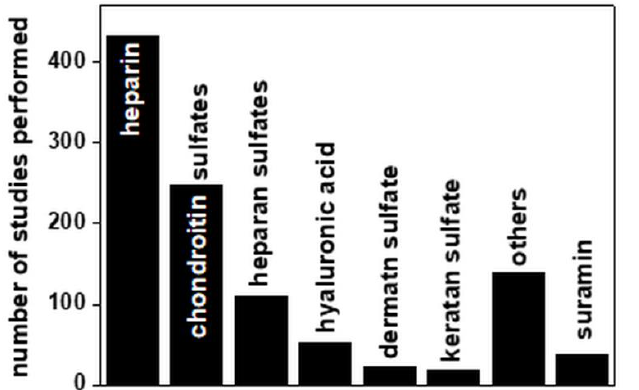
Figure 12. Distribution of computational studies among the different GAGs. The bar “others” includes other natural GAGs and synthetic GAG-mimicking compounds. For further details on the bibliographic research strategy, see Appendix A.